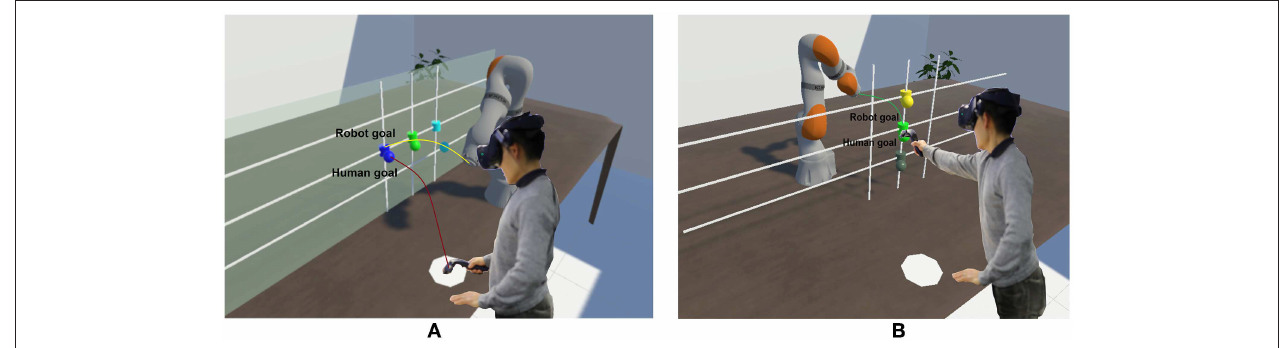
FIGURE 2 | Experiment setup with different configurations: (A) Human and robot are on the same side. (B) Robot is on the opposite side of the